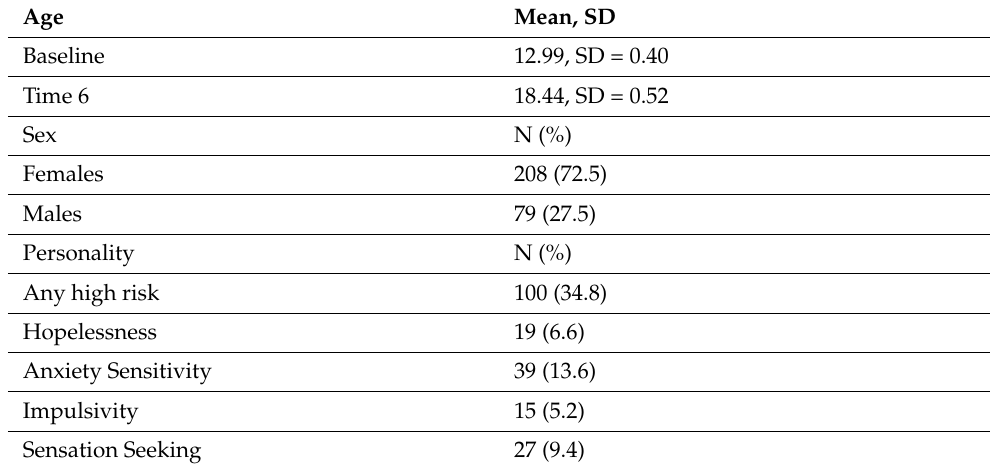
Table 1. Demographic and personality characteristics of the sample, N = 287.